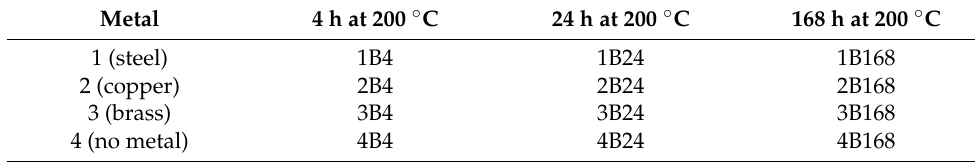
Table 1. Sample codes of the IL